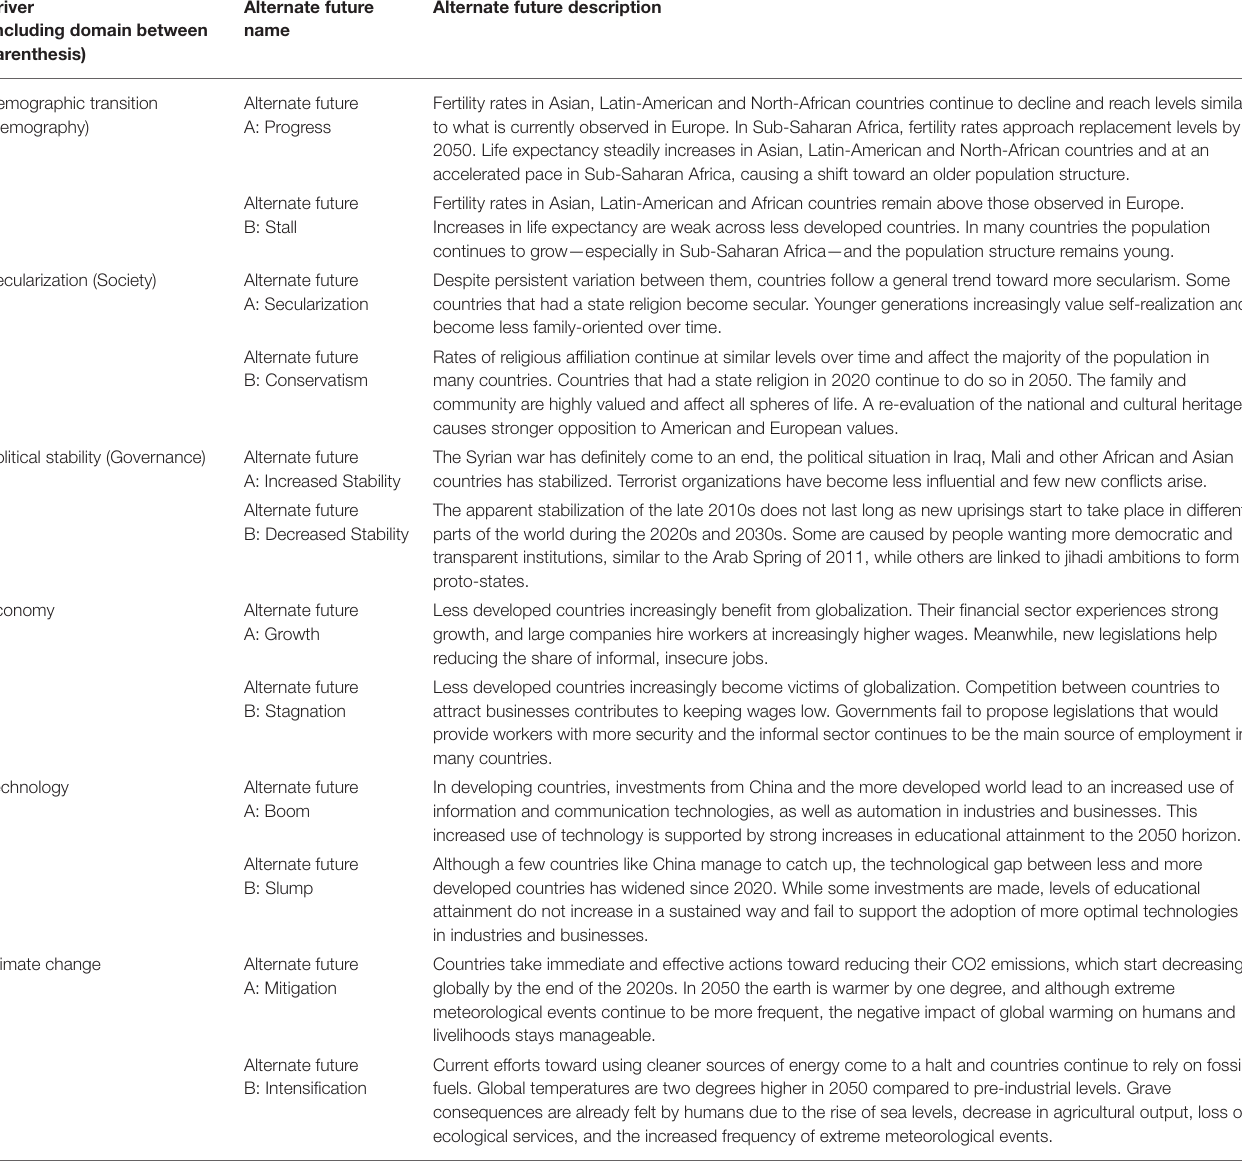
TABLE 2 | Overview of scenarios of change within each domain, less developed countries. Driver (including domain